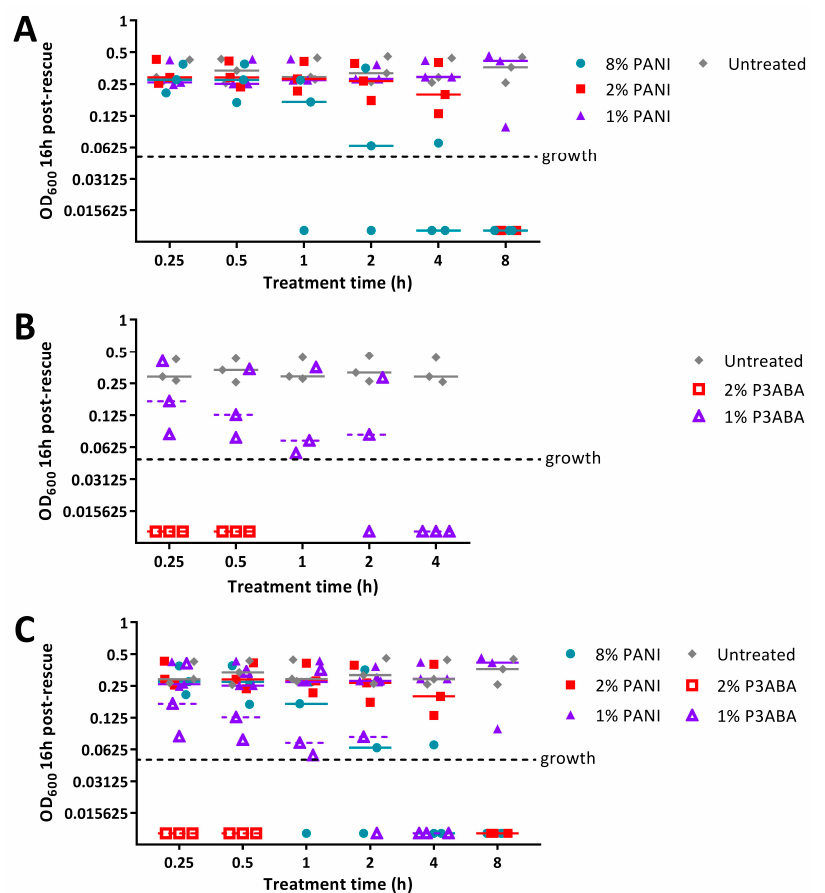
Figure 5. Sensitivity of S. aureus 6538 to PANI in agar. ( A ) ~10 4 CFU of S. aureus was exposed to 8% PANI, 2% PANI, and 1% PANI incorporated into LB agar for 0.25 h, 0.5 h, 1 h, 2 h, 4 h, and 8 h. ( B ) ~10 4 CFU of S. aureus was exposed to 2% P3ABA and 1% P3ABA incorporated into LB agar for 0.25 h, 0.5 h, 1 h, 2 h, and 4 h. Following treatment, the cells were rescued by washing the agar surface with LB broth and transferred to a 96 well plate. Each point represents the median of three technical replicates and each bar represents the median of each biological replicate. The data from A and B is combined for comparison in ( C ). The rescued cells were incubated at 37 °C for 16 h and optical density at 600 nm (OD 600 ) was measured. The vertical axis shows the OD 600 measurements from the recovered cells with each data point representing an independent experiment and the line representing the median. OD 600 readings above 0.05 are considered as growth.